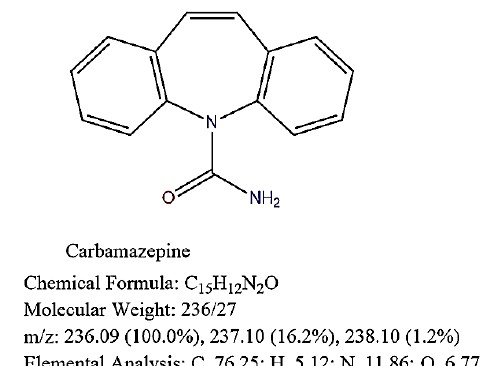
Figure 1: Chemical structure and specifications of Carbamazepine.